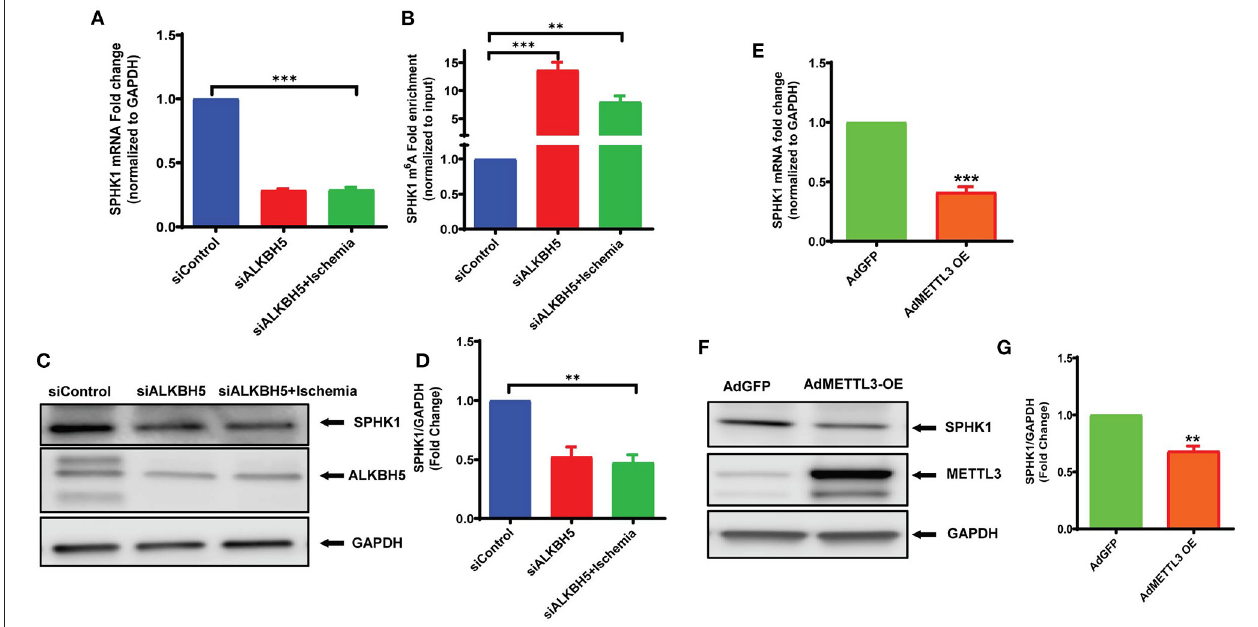
FIGURE 6 | ALKBH5 silencing increased SPHK1 m 6 A mRNA methylation. mRNA was isolated for both RT-qPCR (no immunoprecipitation –nonIP) and MeRIP (m 6 A methyl RNA immunoprecipitation) followed by MeRIP-qPCR. (A) RT-qPCR for SPHK1 showing decreased mRNA expression. (B) MeRIP-qPCR showing the m 6 A abundance on SPHK1 mRNA under given conditions. As expected, m 6 A mRNA methylation of SPHK1 was increased after ALKBH5 siRNA knockdown. Data is presented as m 6 A fold enrichment after normalization with nonIP input. (C) WB and (D) quantification of SPHK1 protein after ALKBH5 silencing with and without ischemic stimulus. ALKBH5 silencing alone or ischemia significantly reduced SPHK1 expression. (E–G) METTL3 was overexpressed using METTL3 adenovirus. METTL3 overexpression significantly reduced both SPHK1 gene (E) and protein expression (F,G) . SPHK1 bands intensity was measured with ImageJ (NIH) software. ** P < 0.01, *** P < 0.001, ns indicates not significant with respective control ( n =